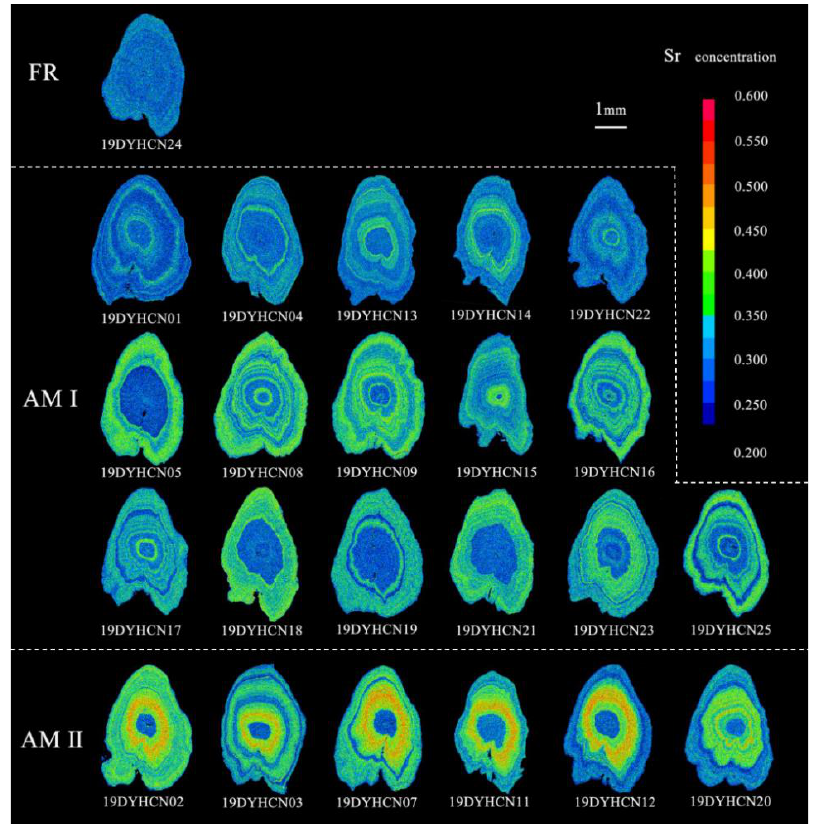
Figure 3. Sagittal plane of the otolith etched with EDTA. ( a ) The white dashed line denotes the transect direction of the Sr/Ca ratio, and the arrows show the annuli. ( b ) Two-dimensional X-ray intensity map of the Sr concentrations.